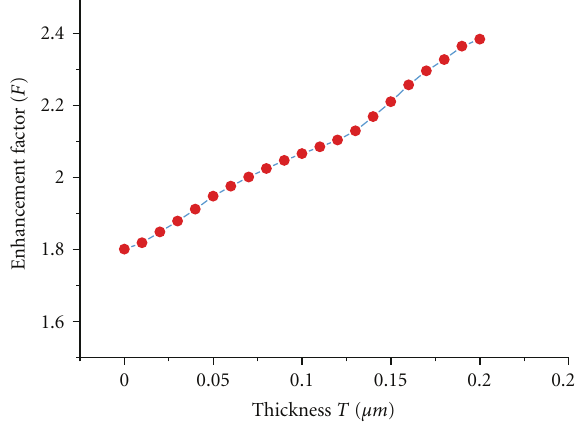
Figure 8: The vertical low-order modes profiles of the OLEDs structure with embedded ITO PhCs. The region in the red rectangle is the PhCs layer.